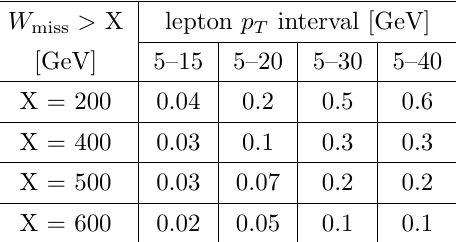
Table 4 . Event yields at 300 fb (cid:0) 1 for exclusive WW production via leptonic decays, for four W miss cut values (corresponding to the four mass scenarios considered in this study) and four lepton p T intervals, after applying all cuts speci(cid:12)ed in table 2. Yields correspond to the sum of (cid:22) + (cid:22) (cid:0) and e + e (cid:0) (cid:12)nal states observed in j (cid:17) j < 2 : 5. Lepton reconstruction e(cid:14)ciencies taken from